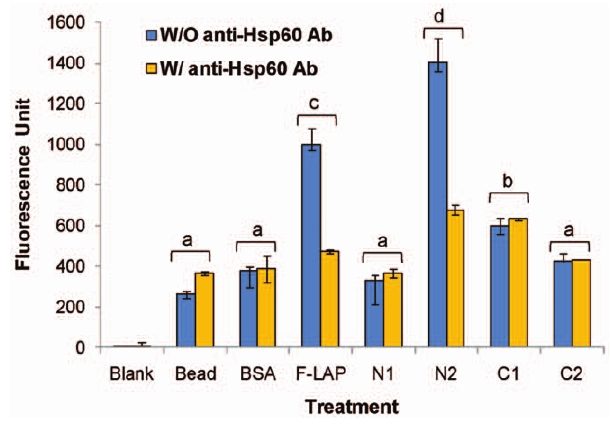
Figure 3. Bar graph showing binding of LAP subdomains- coated fluosphere (1 m m diameter) to human ileocecal epithe- lial HCT-8 cell monolayers. Among the subdomains, N2-coated fluospheres showed the most adherences compared to N1, C1, and C2. As a positive control, full-length LAP (F-LAP) - coated fluospheres also showed strong binding. Fluospheres alone (bead) and BSA-coated fluospheres (BSA) had also significantly (P , 0.05) low binding. Pretreatment of HCT-8 monolayers with anti-Hsp60 MAb significantly (P , 0.05) reduced the binding of N2-coated and F-LAP-coated fluo- spheres. Data are average of 3 independent experiments run in duplicate and presented with standard error of mean (SEM). Values labeled with different letters (a, b, c, d) are significantly different at